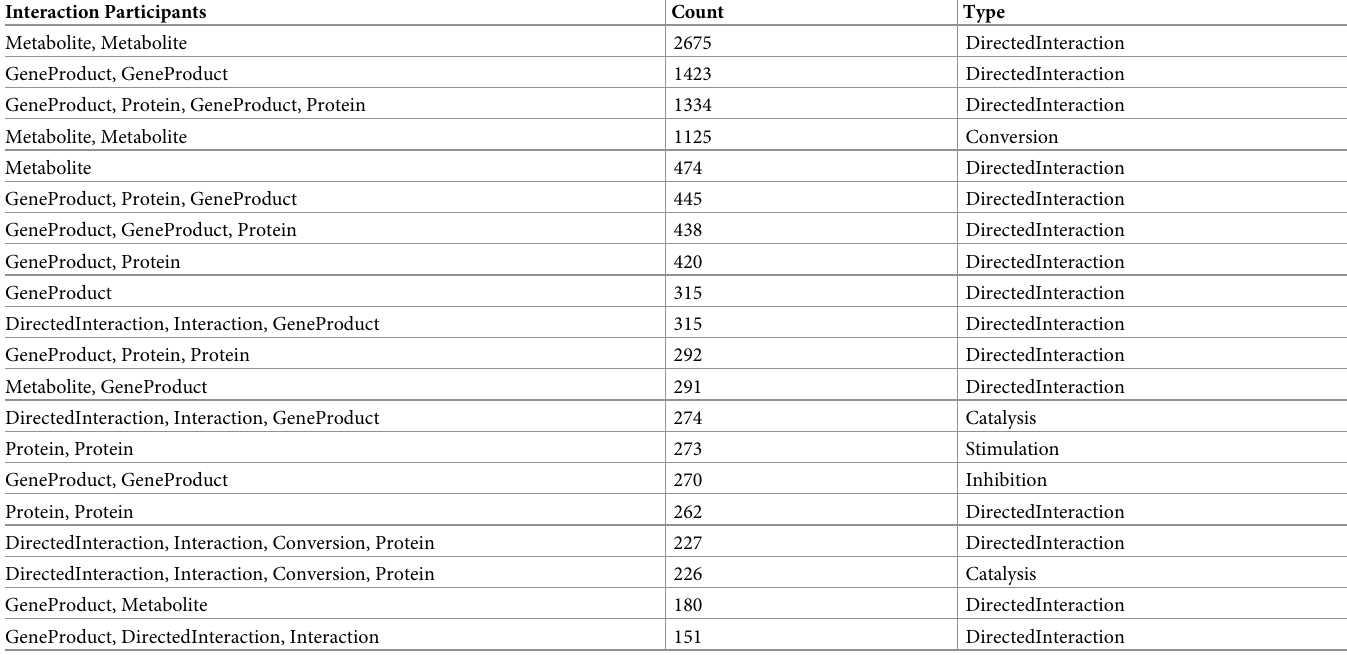
Table 6. Top 20 most occurring directional interactions by participants combination. The most abundant interaction is a directed interaction between two metabolites. Interaction participants, the count of how many there are in the WikiPathways RDF and the type of interactions are